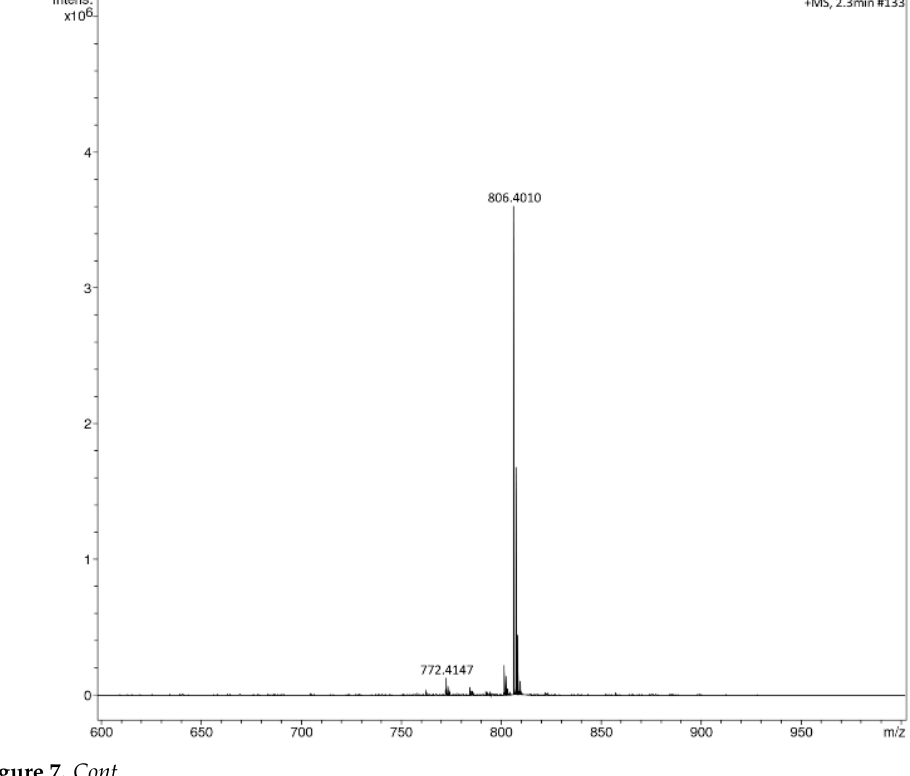
The HRMS results showed molecular ion peaks at 806.3999 (m/z) [M + Na] + ,indicating the presence of beauvericin (C 45 H 57 N 3 O 9 ) in the fungal extracts (Figure 7). Similar (m/z) [M + Na] + 806.3956 have been reported for beauvericin (C 45 H 57 N 3 O 9 ) [71]. It was observed